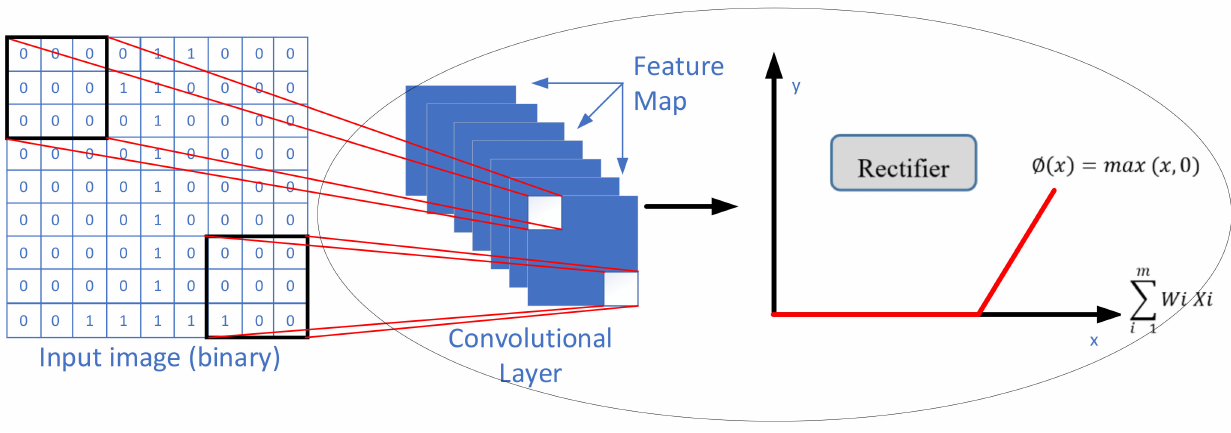
Figure 7. ReLU layer function applied in convolutional layer process.